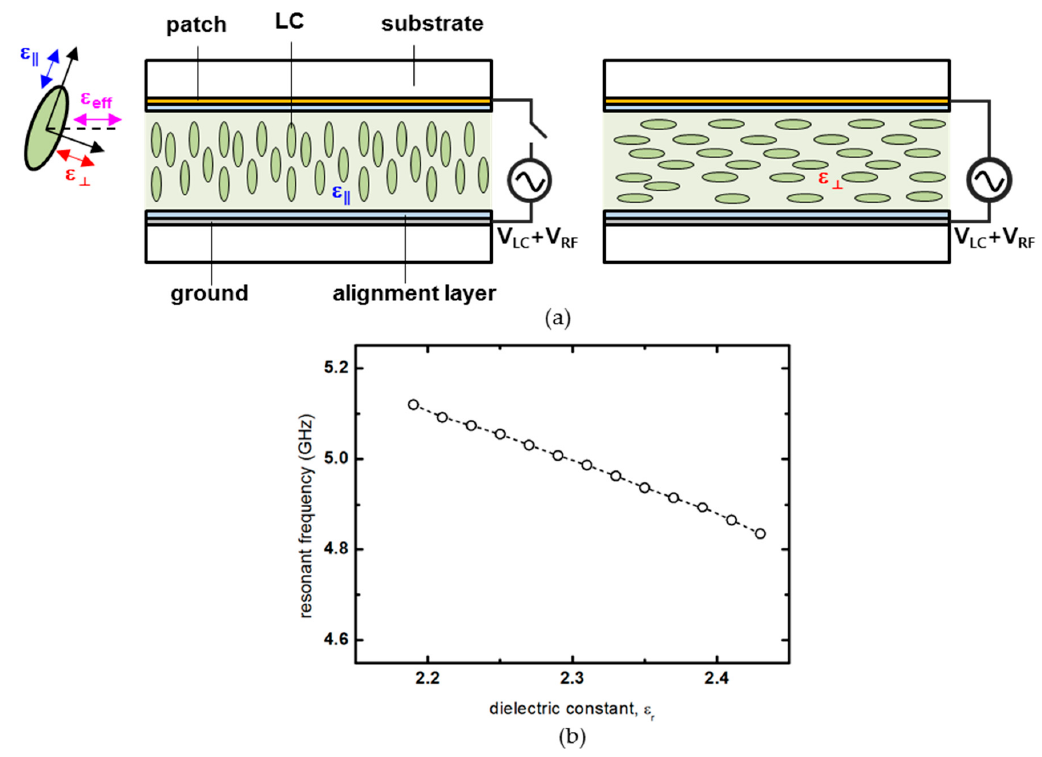
Figure 2. ( a ) Schematic diagram of dielectric anisotropy according to the voltage applied to the vertically aligned liquid crystal used as the substrate of the patch antenna. ( b ) Resonant frequency change according to a dielectric constant of liquid crystal.